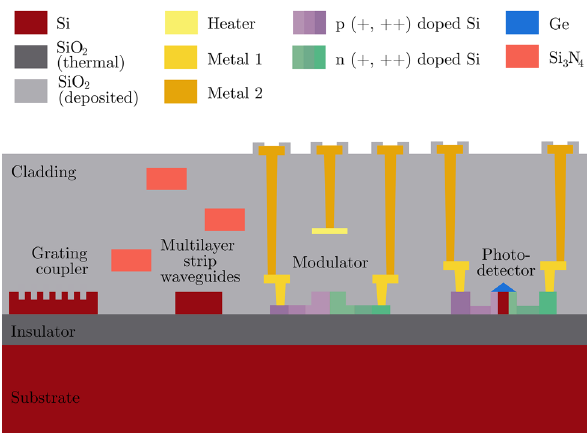
Figure 5: Schematic of the cross section of different integrated photonic devices fabricated with multilayer silicon nitride on submicron silicon-on-insulator process, comprising a grating coupler, strip waveguides, a modulator, and a photodetector (not to scale). It illustrates the different materials and process steps required during the